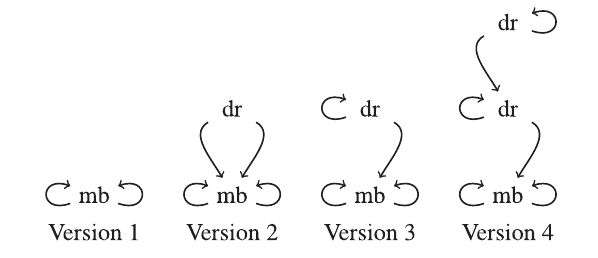
TABLE2| Differentinformationstatesconsideredin(13) – (16).Abbreviations:dr: A Day at the Races is showing, mb: Monkey Business is showing. Each node represents a possible world. Arrows w → v say that v is an epistemic possibility in world w ; arrows to the left point to possible worlds of the speaker ’ s information state, arrows to the right to possible worlds of the hearer ’ s information state.